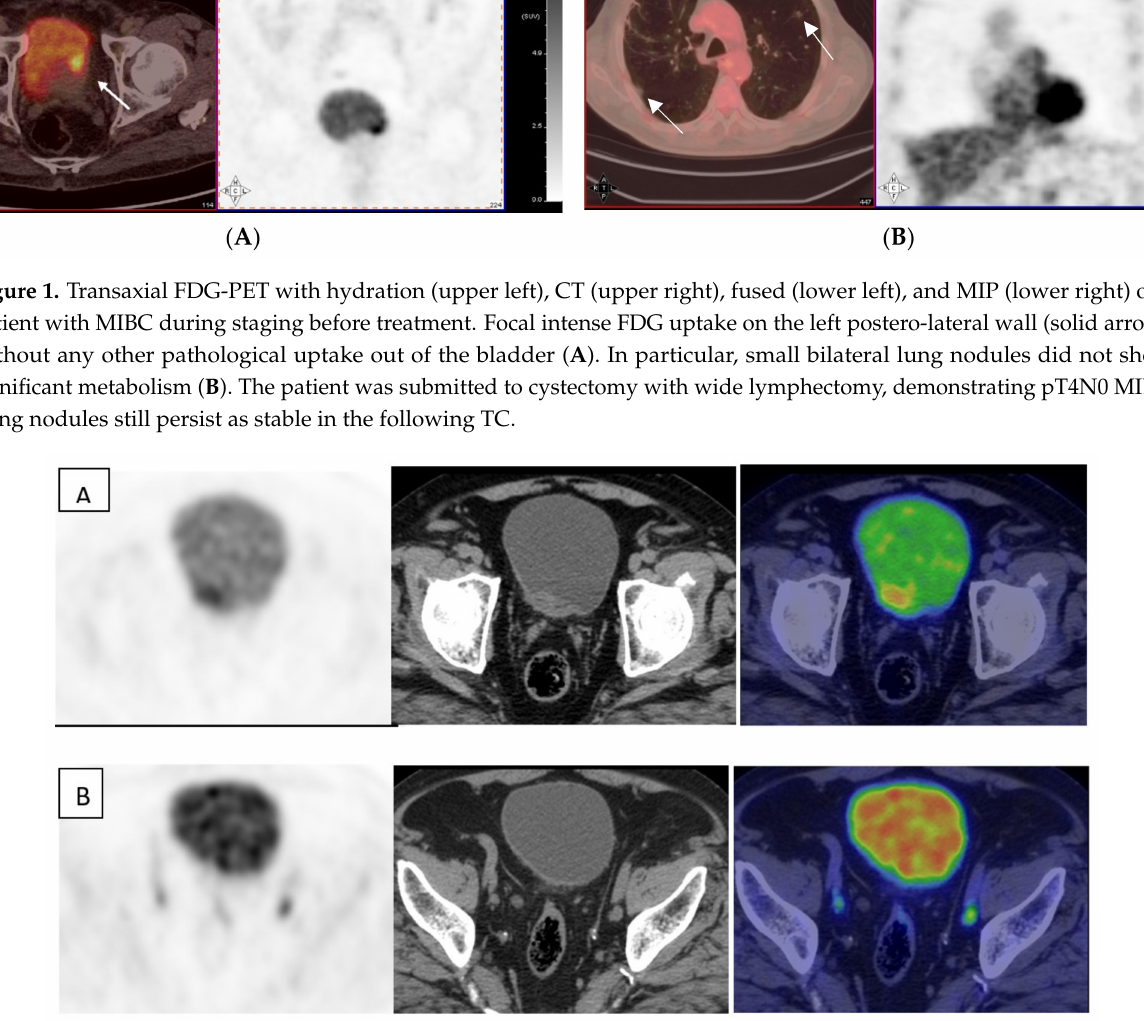
Figure 2. Transaxial FDG-PET with hydration (left), CT (center), and fused (right) images of MIBC in the posterior wall. Intense glucose metabolism in the primary tumor higher than FDG urinary excretion is present ( A ). CT images show bilateral iliac lymph nodes enlargement corresponding to focal areas of glucose uptake ( B ). Histology confirmed iliac lymph node